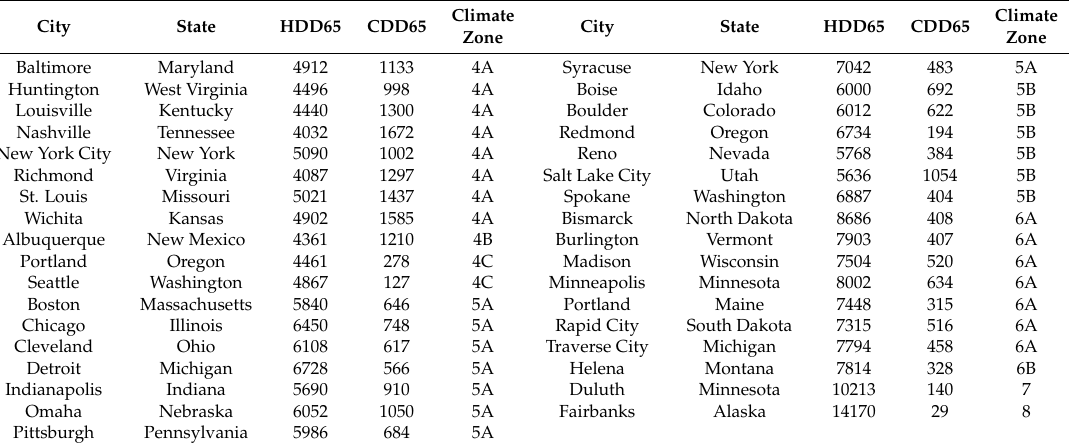
Table 2. Cities from climate zones 4–8 that were used to derive an equation for hourly heating energy savings as a function of outdoor